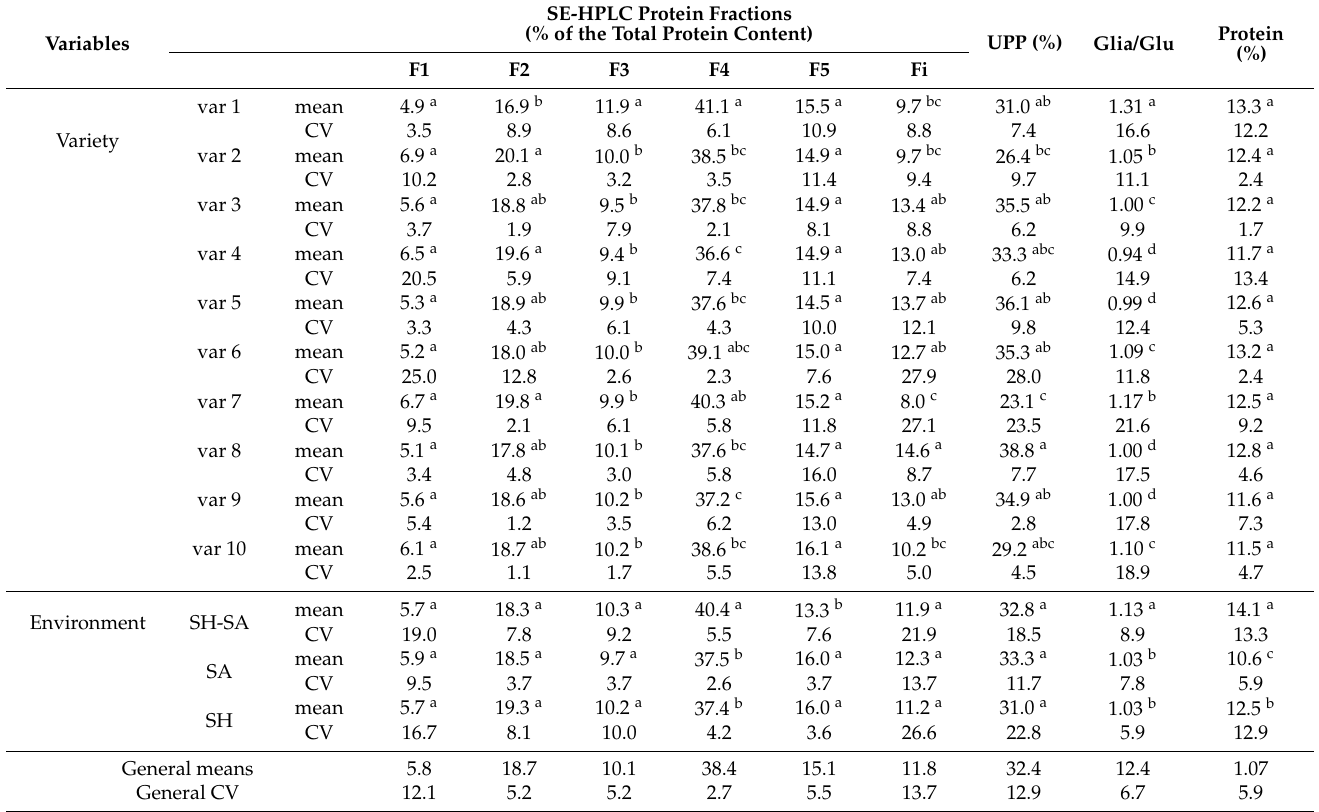
Table 2. Mean and Coefficient of Variation of each parameter according to the variety and the environments.